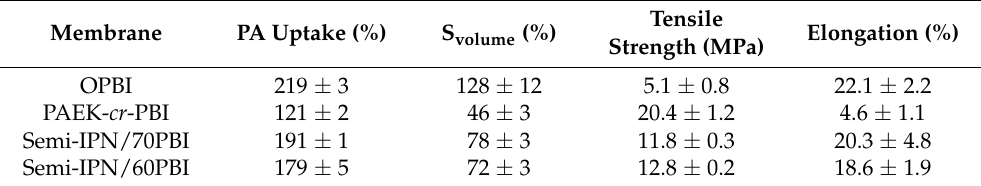
Table 2. PA uptake, swelling, and mechanical properties of all PA doped